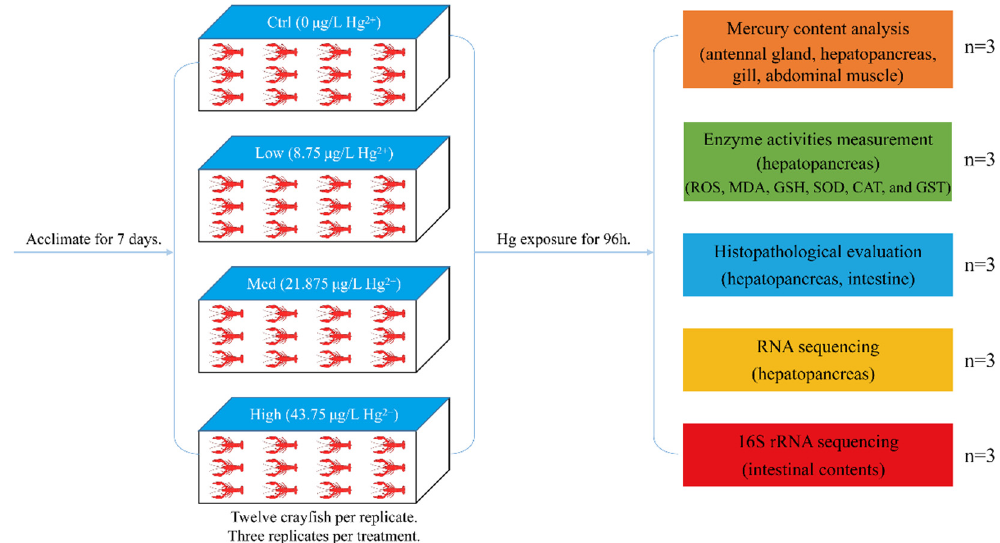
Figure 1. Schematic representation of the experimental procedure.